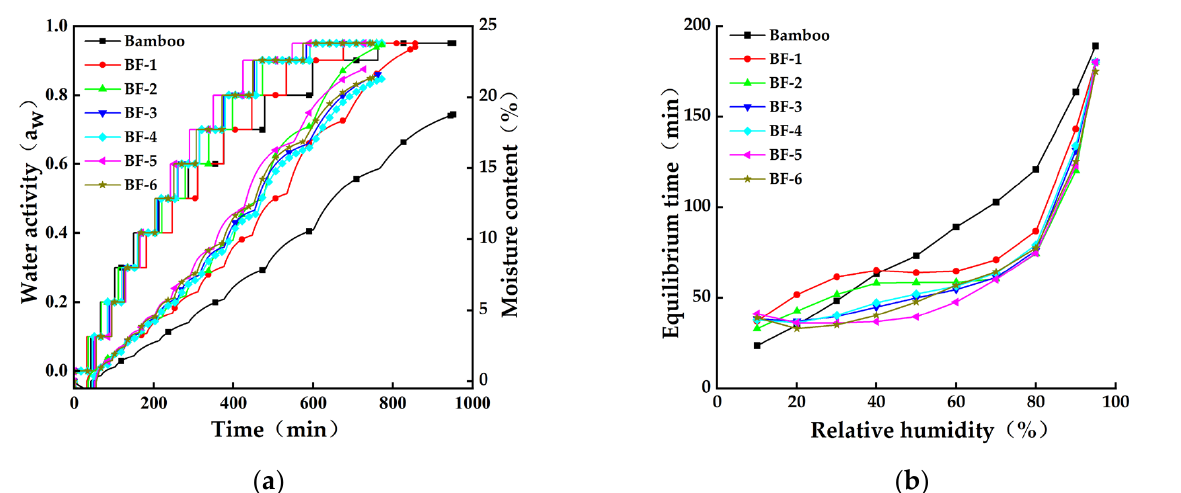
Figure 6. Moisture-adsorption kinetic curve of bamboo fibers with different opening times. ( a ) Water activity and moisture content–time correspondence curve. ( b ) Equilibrium time–relative humidity correspondence curve.